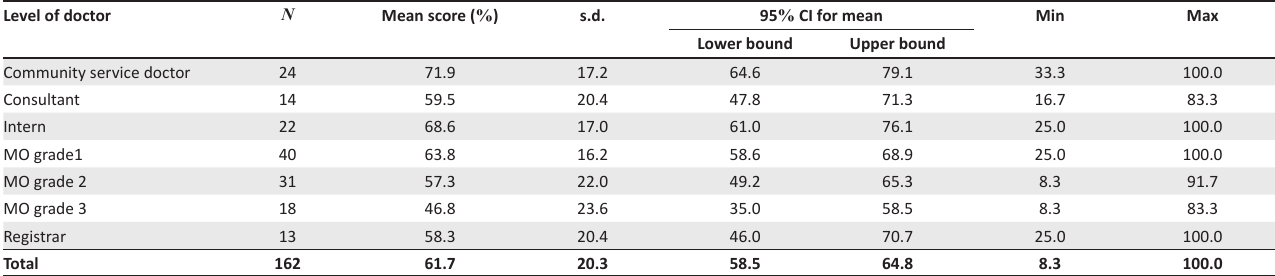
TABLE 3: Knowledge scores by level of doctor